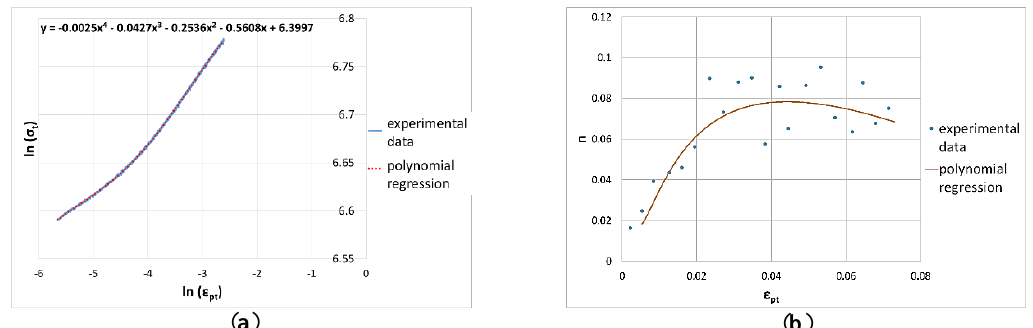
Figure 12. Example of ( a ) true stress-true strain plastic range up to necking initiation in a bi-logarithmic diagram and regression with fourth degree polynomial, ( b ) instantaneous strain hardening coe ffi cient comparison between experimental data and polynomial regression on group